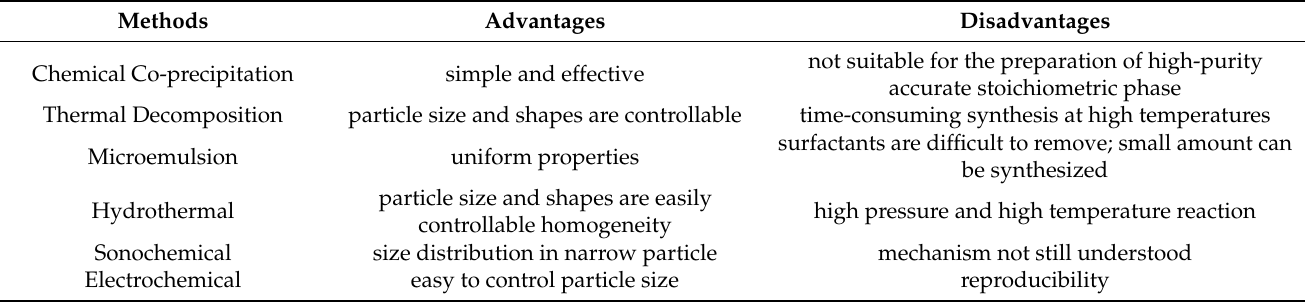
not suitable for the preparation of high-purity accurate stoichiometric phase